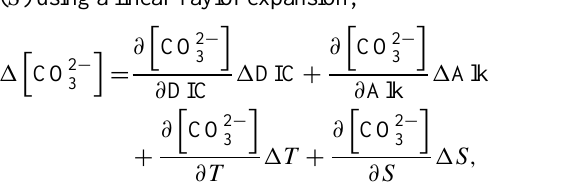
Figure 8. The wavelet time-frequency spectrum for the leading principal component of surface ocean [CO 2 − North Pacific, and (c) North Atlantic regions (mmolm − 3 ) 2 . Black contours indicate statistically significant ( > 95%) spectral